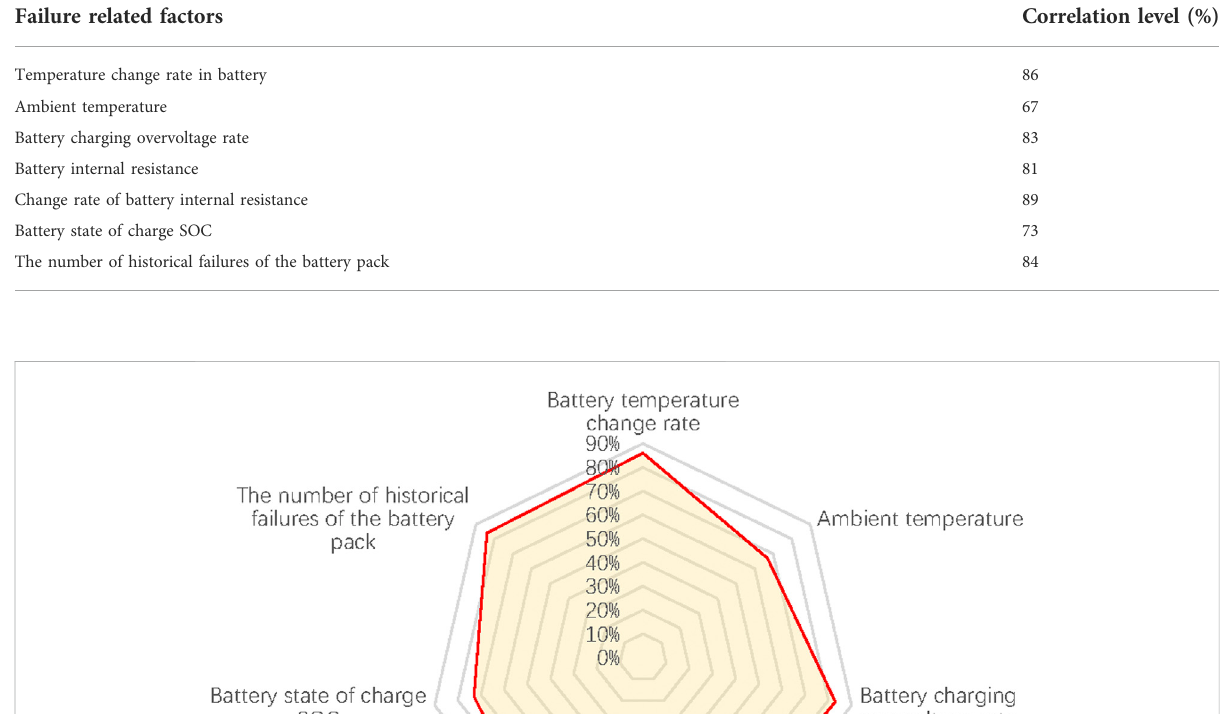
TABLE 7 Correlation level of power battery failure factors.